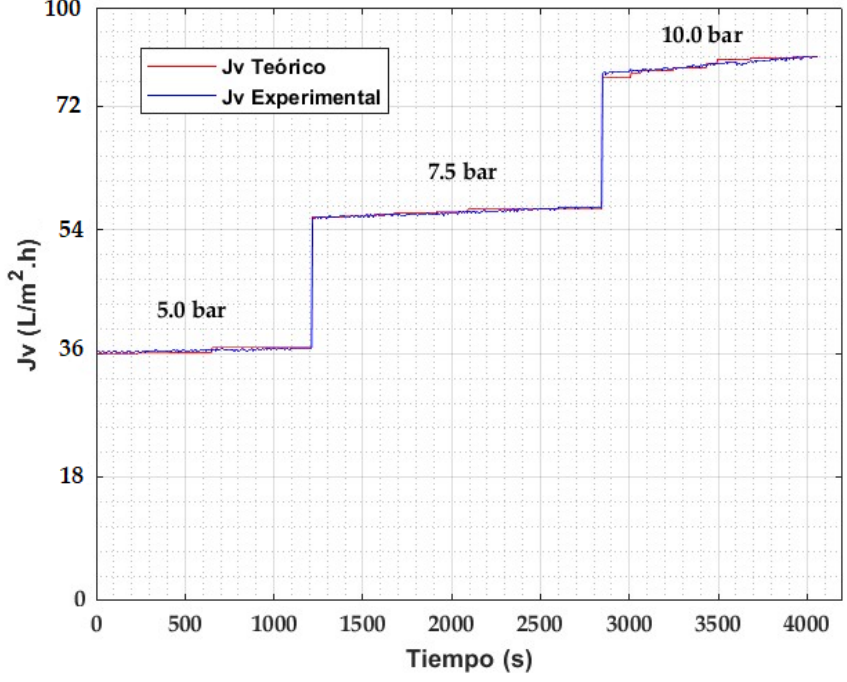
Figure 11. Theoretical vs. experimental flux of Pb: low concentration.